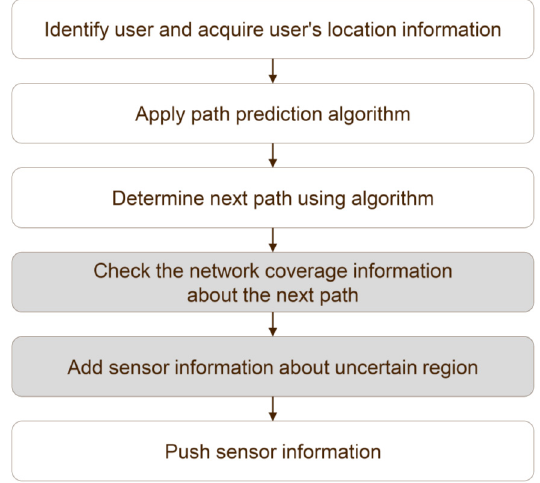
Figure 5. Overall procedure for providing sensor information.